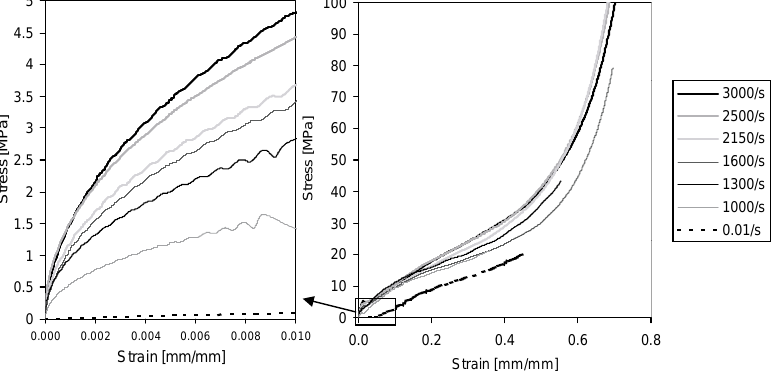
Fig. 12. Stress-strain curves for polyurethane